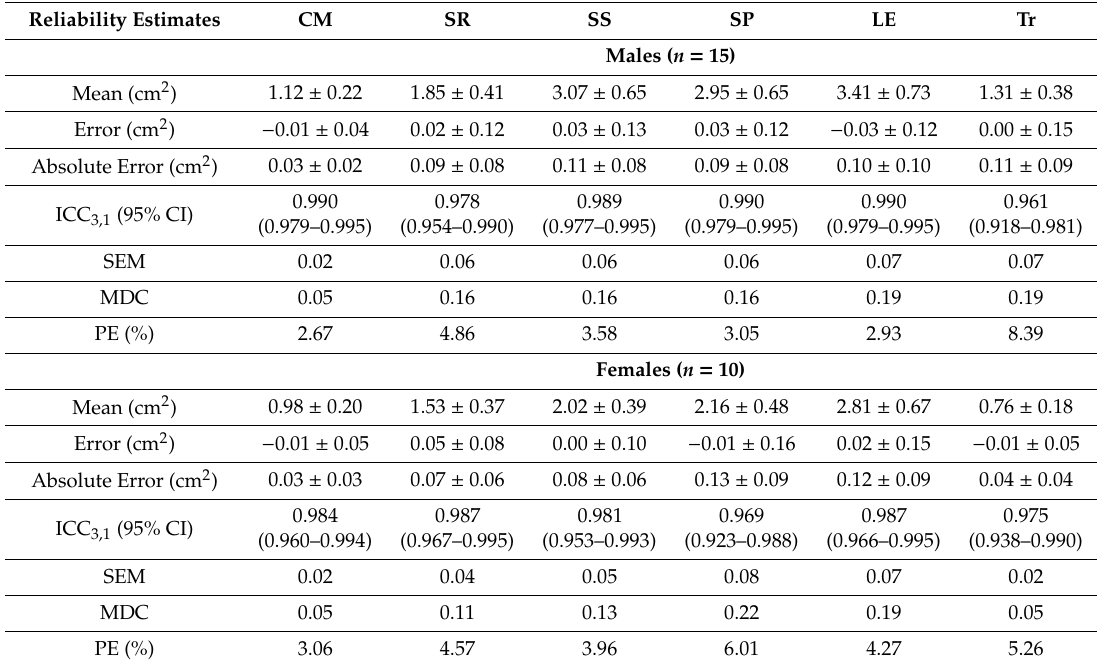
Table 3. Intra-examiner reliability of panoramic ultrasound imaging by